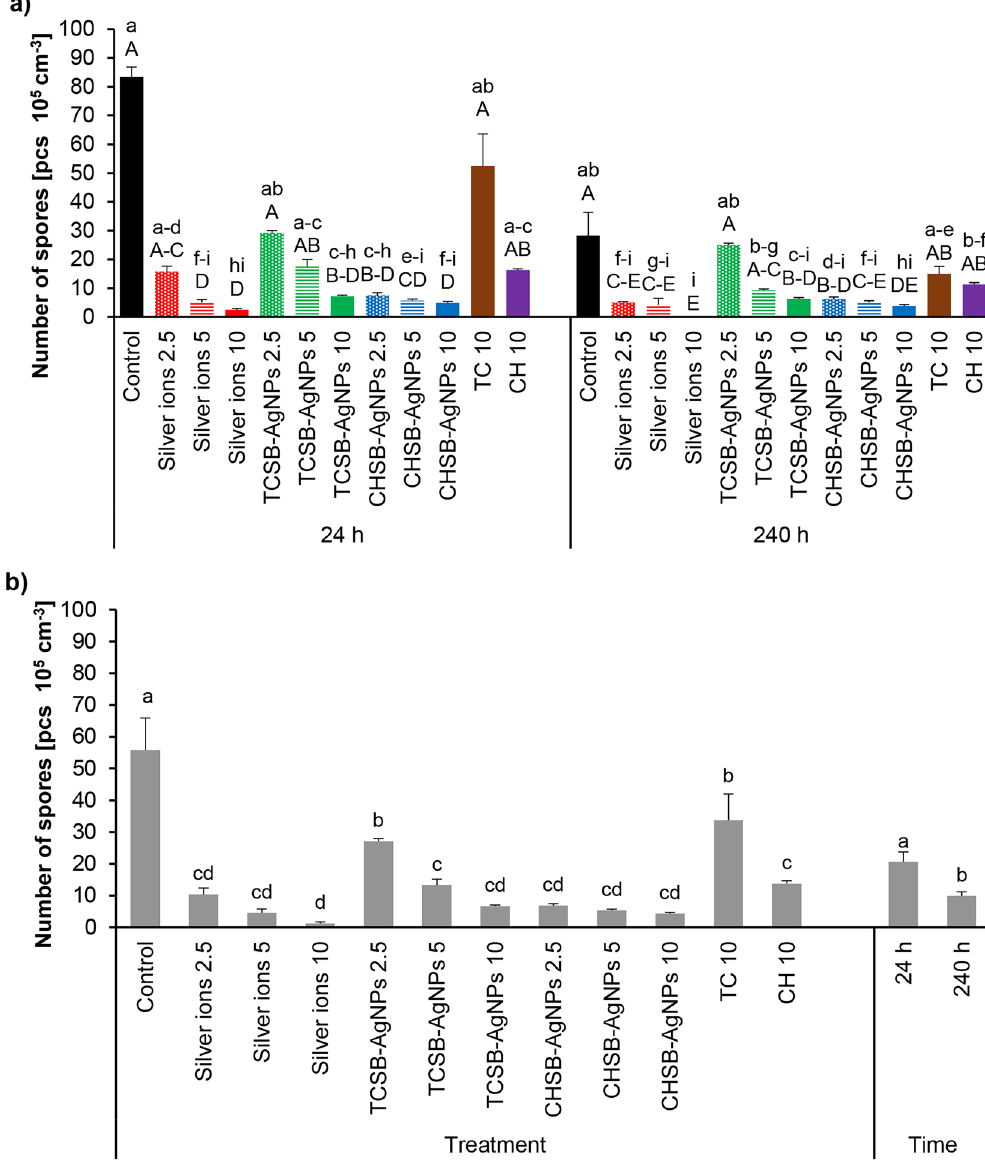
show the high values of the initial data variability, i.e. 81.43% for the short treatment and 97.73% for the long treatment, which proves the effectiveness of the test performed. The effect of investigating compounds on fungi in the short treatment (24 h) showed that TCSB-AgNPs at concentrations of 2.5 and 5 mg L −1 had no global effect on sporulation, growth and the growth rate index in F. avenaceum compared to the control. It was found that TCSB-AgNPs at a concentration of 10 mg L −1 , CHSB-AgNPs and silver ions at a concentration of 2.5 mg